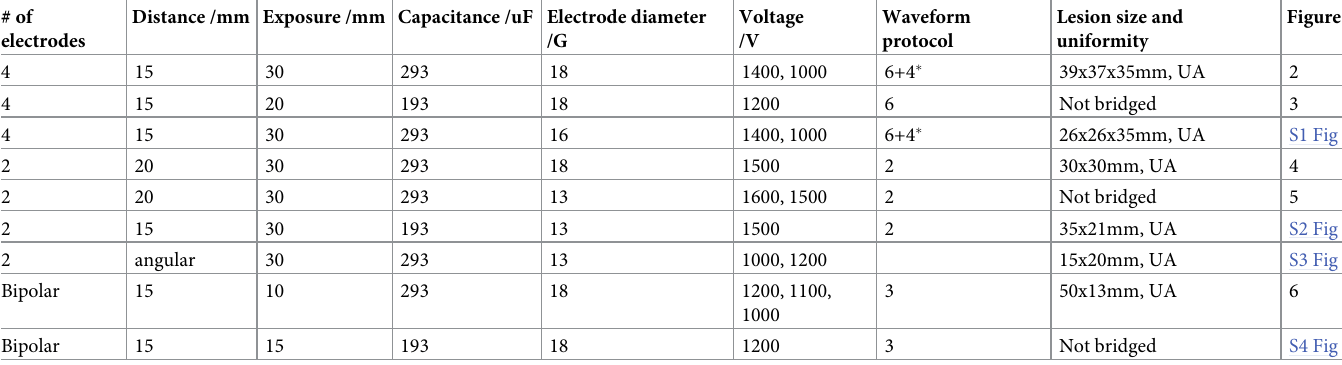
Table 1. Relevant parameters for the experiments which were conducted in this study. # of Distance /mm Exposure /mm Capacitance /uF Electrode diameter electrodes